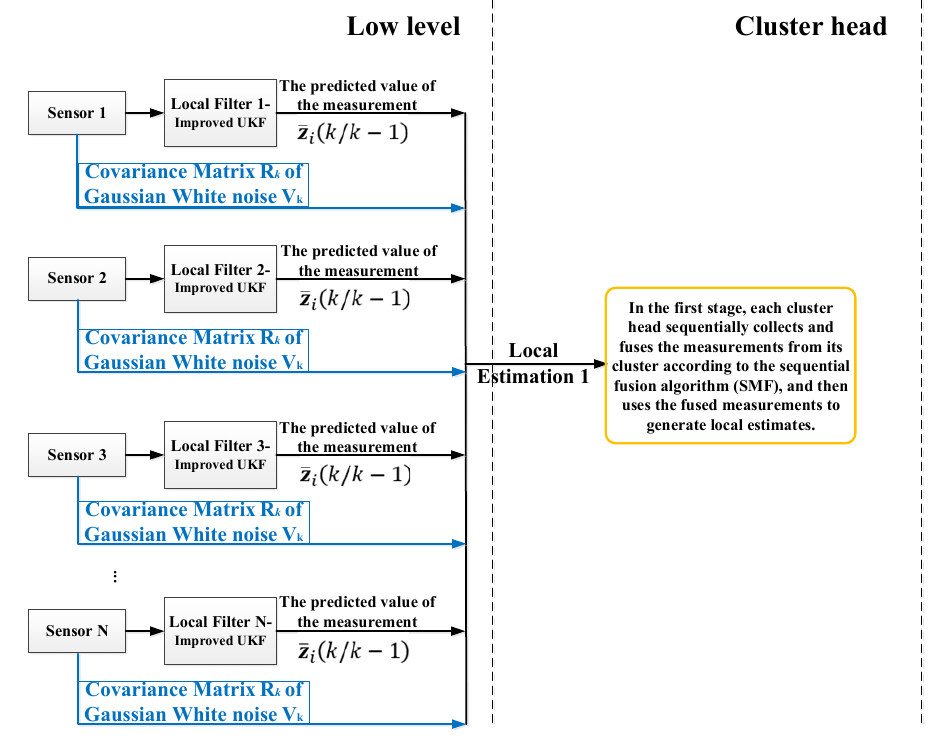
Figure 6. Framework of local fusion estimation algorithm.